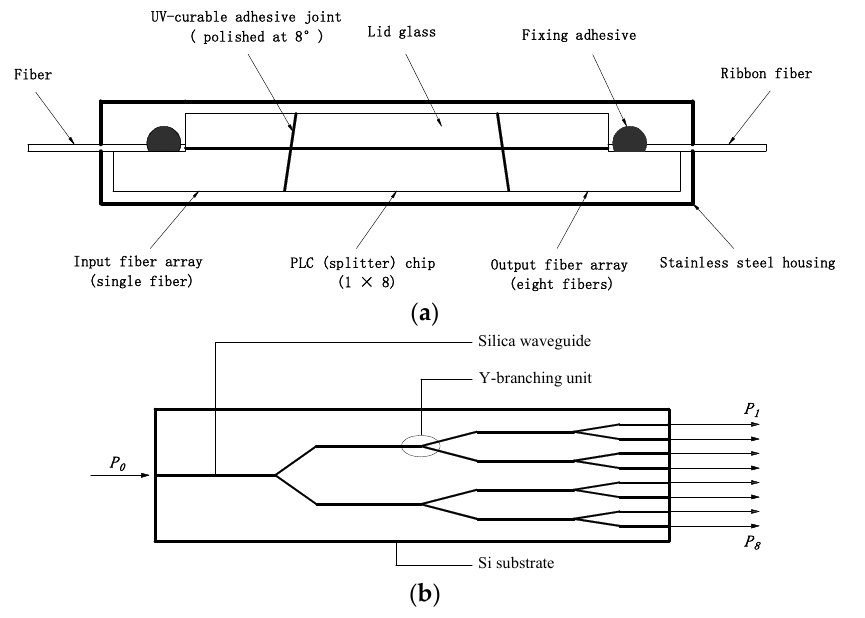
Figure 1. The typical structure of 1 × 8 PLC optical splitters: ( a ) side view of a PLC optical splitter module and ( b ) the top view of the PLC (splitter) chip [22].